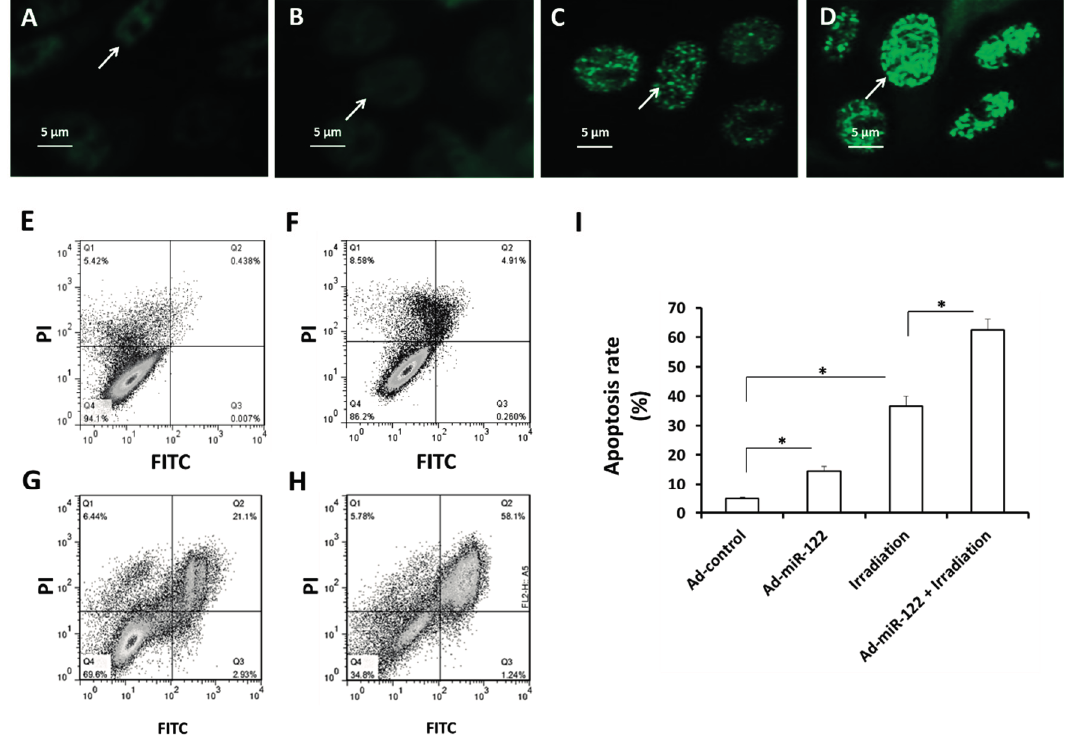
Figure 3. MiR-122 enhances the DNA double strands break (DSB) and apoptosis induced by IR in A549 cells. ( A – D ) A549 cells, infected with Ad-control or Ad-miR-122, were then treated without or with 6Gy IR. ( A – D ) Then, the Immunocytochemistry assays were performed. The γ -H2AX foci formation in the nucleus was shown as typical photograph ( A – D ); ( E – I ) A549 cells, which were infected with Ad-control ( E , G ) or Ad-miR-122 ( F , H ), were treated with IR ( G , H ) or not ( E , F ). Next, cells were harvested and examined by apoptosis analysis. The apoptotic cells were shown as typical photograph ( E – H ) or percentage of apoptosis cells (mean ± SD) from triplicate experiment with similar results ( I ). Arrows “ ↑ ” indicate the γ -H2AX foci formation (granule formation) in cellular nuclear ( A – D ), * p < 0.05 versus Ad-control or Ad-miR-122, * p < 0.05 versus without or with 6Gy